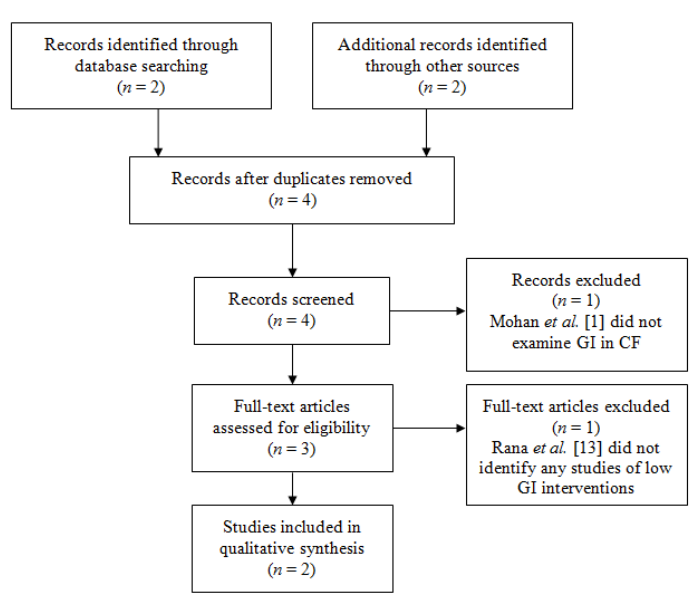
Figure 1. Study selection